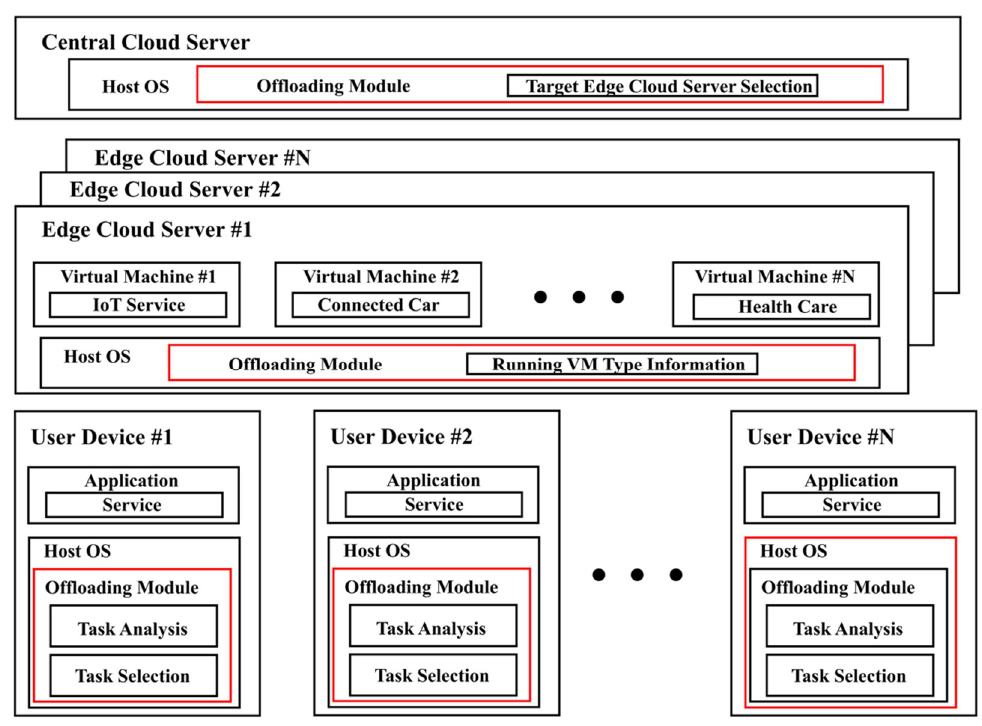
Figure 3. System architecture of the LCDA.